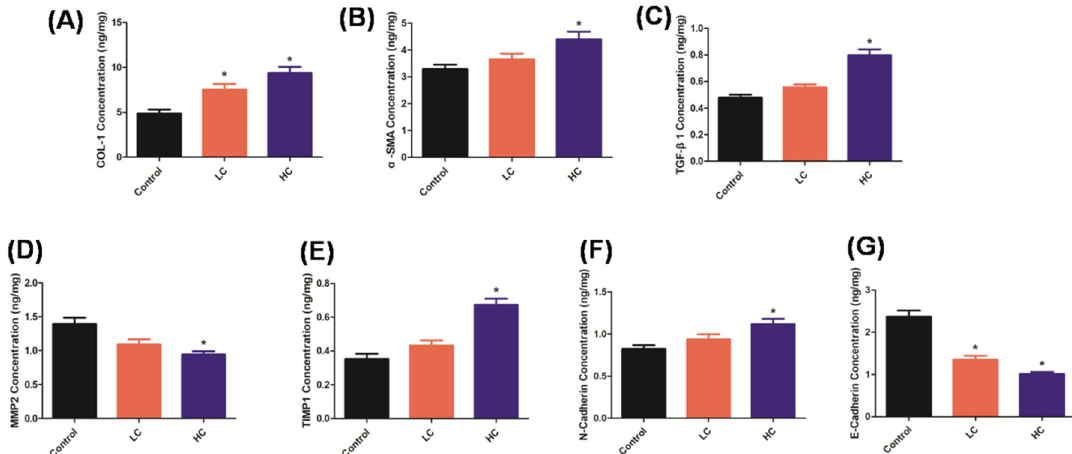
Figure 2. PF biomarkers were determined via ELISA assay after OMPM exposure at different concentrations in rat serum and lung tissues. ( A ) COL-1 concentration; ( B ) α -SMA concentration; ( C ) TGF- β 1 concentration; ( D ) MMP2 concentration; ( E ) TIMP1 concentration; ( F ) N-cadherin concentration; ( G ) E-cadherin concentration. Data represent mean ± SD. * p < 0.05 vs. the control group.